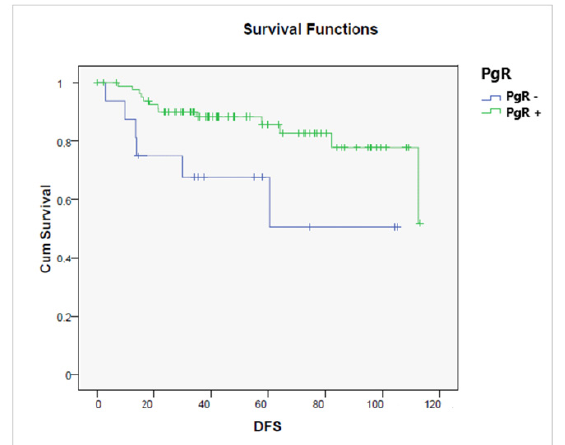
Figure 6. Disease ‐ free survival according to the presence or absence of a progesterone receptor (PgR − vs. PgR+, p = 0.011).